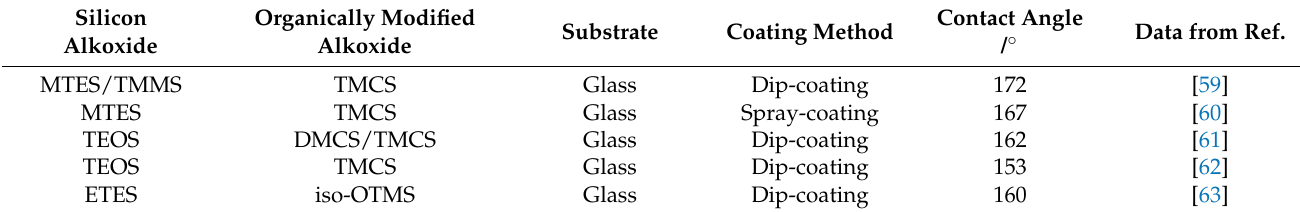
Table 2. Two-step syntheses of hydrophobic silica films. Silicon